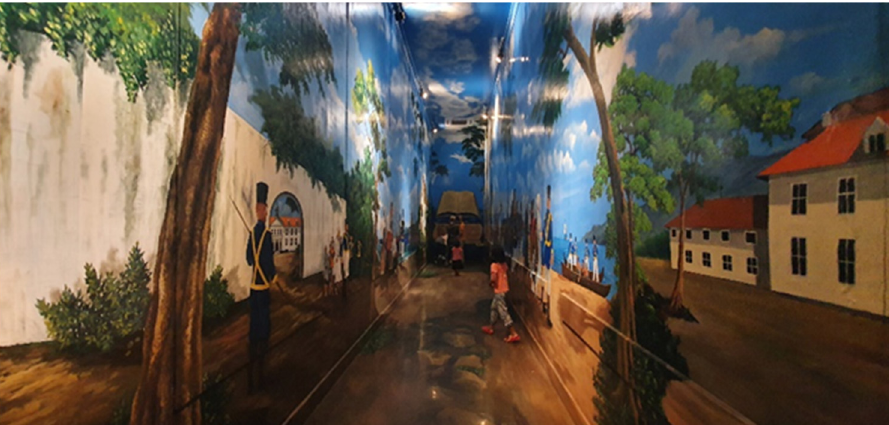
Figure 5: The 3D mural representing Prince Diponegoro ’ s Java